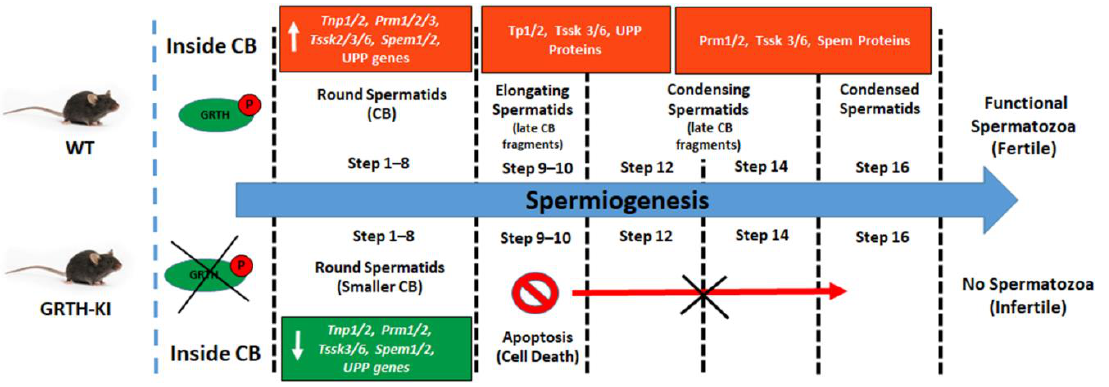
Figure 6. Schematic diagram showing progression of the spermatogenesis process in the presence and absence of pGRTH, with reference to chromatoid bodies and the associated mRNA and protein expression. Loss of phospho-GRTH altered the CB structure and biochemical composition. It also diminished the transport of essential transcripts between cytoplasm and CBs, thereby altering the mRNA storage profiles and causing impaired spermatid elongation, resulting in loss of spermatozoa and subsequently infertility.